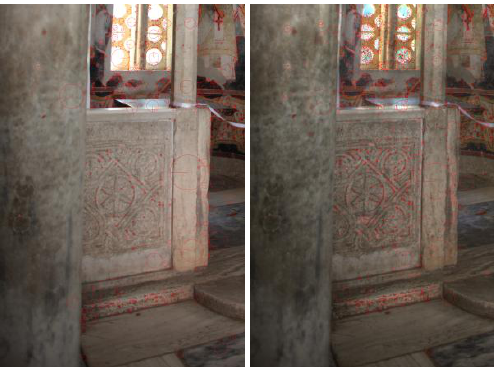
Figure 3: Features detected with SIFT (detail) (a) on the SDR image and (b) on the HDR